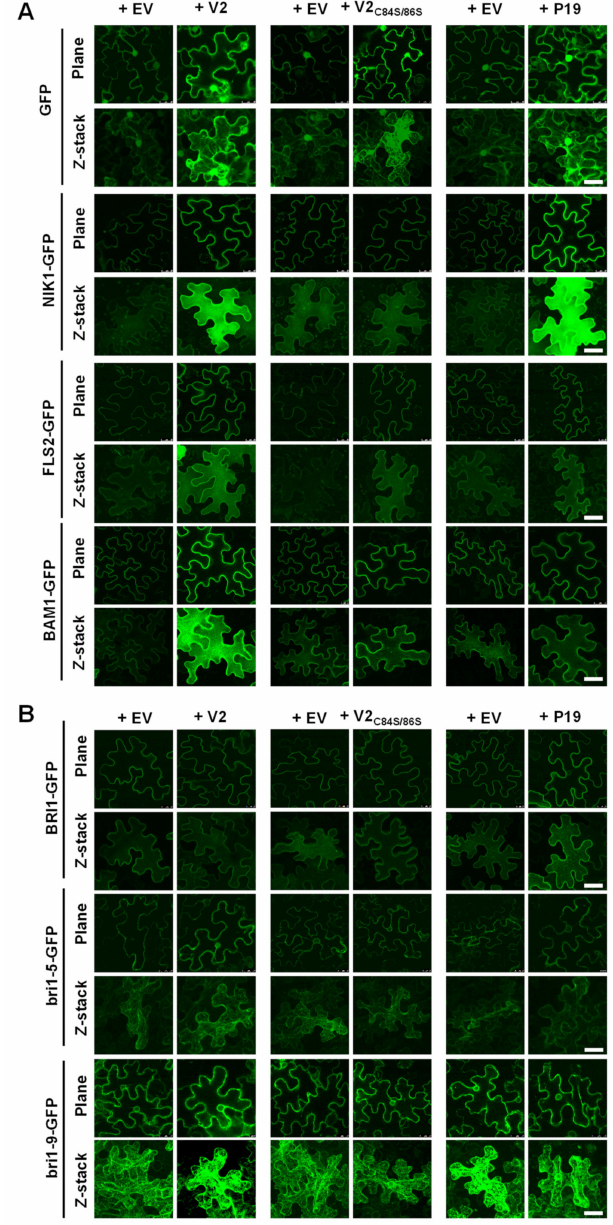
Figure 2. V2 does not interfere with the subcellular localization of plasma membrane-localized plant receptor-like kinases. N. benthamiana leaves were infiltrated with A. tumefaciens carrying constructs to express V2, V2 C84S/C86S , or p19, and GFP, NIK1-GFP, FLS2-GFP, or BAM1-GFP ( A ) and BRI1-GFP, bri1-5-GFP, or bri1-9-GFP ( B ), respectively; A. tumefaciens carrying an empty vector (EV) were used as negative control. Protein accumulation was observed under the confocal microscope at 2